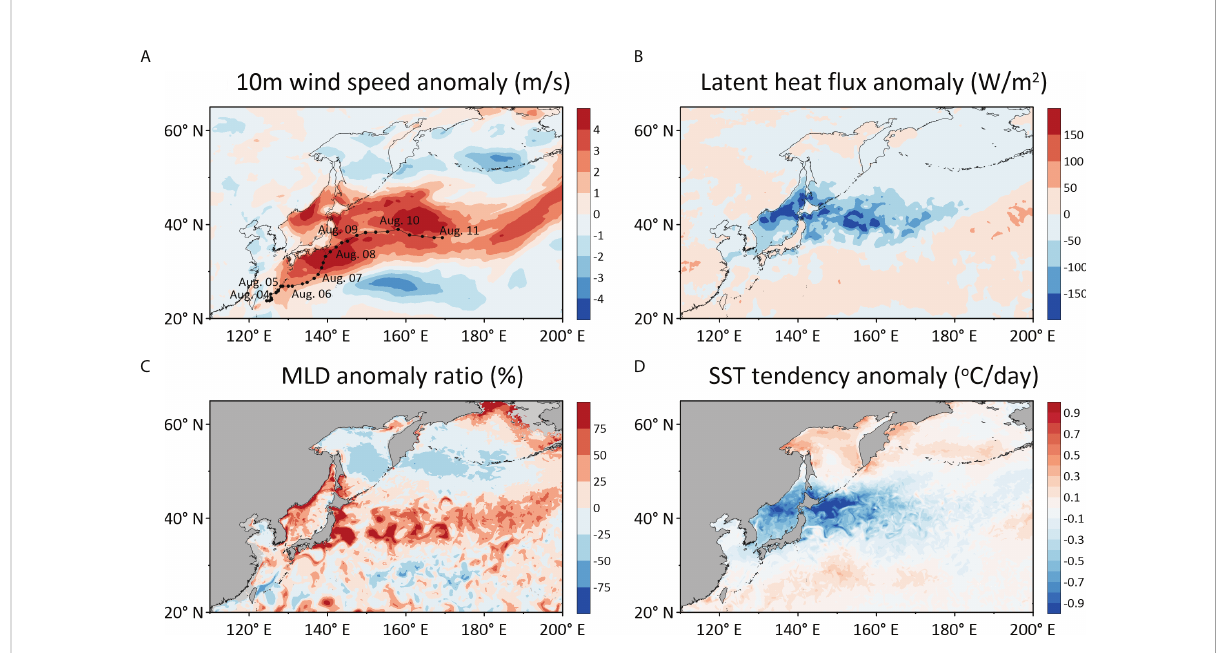
FIGURE 6 Spatial maps depicting the distribution of the (A) 10-m wind speed anomaly with best track of Typhoon Mirinae, (B) latent heat fl ux anomaly, (C) ratio of the mixed-layer depth (MLD) anomaly to climatological MLD, and (D) sea surface temperature (SST) tendency anomaly in the cooling period of 2021 relative to 2001 – 2020.